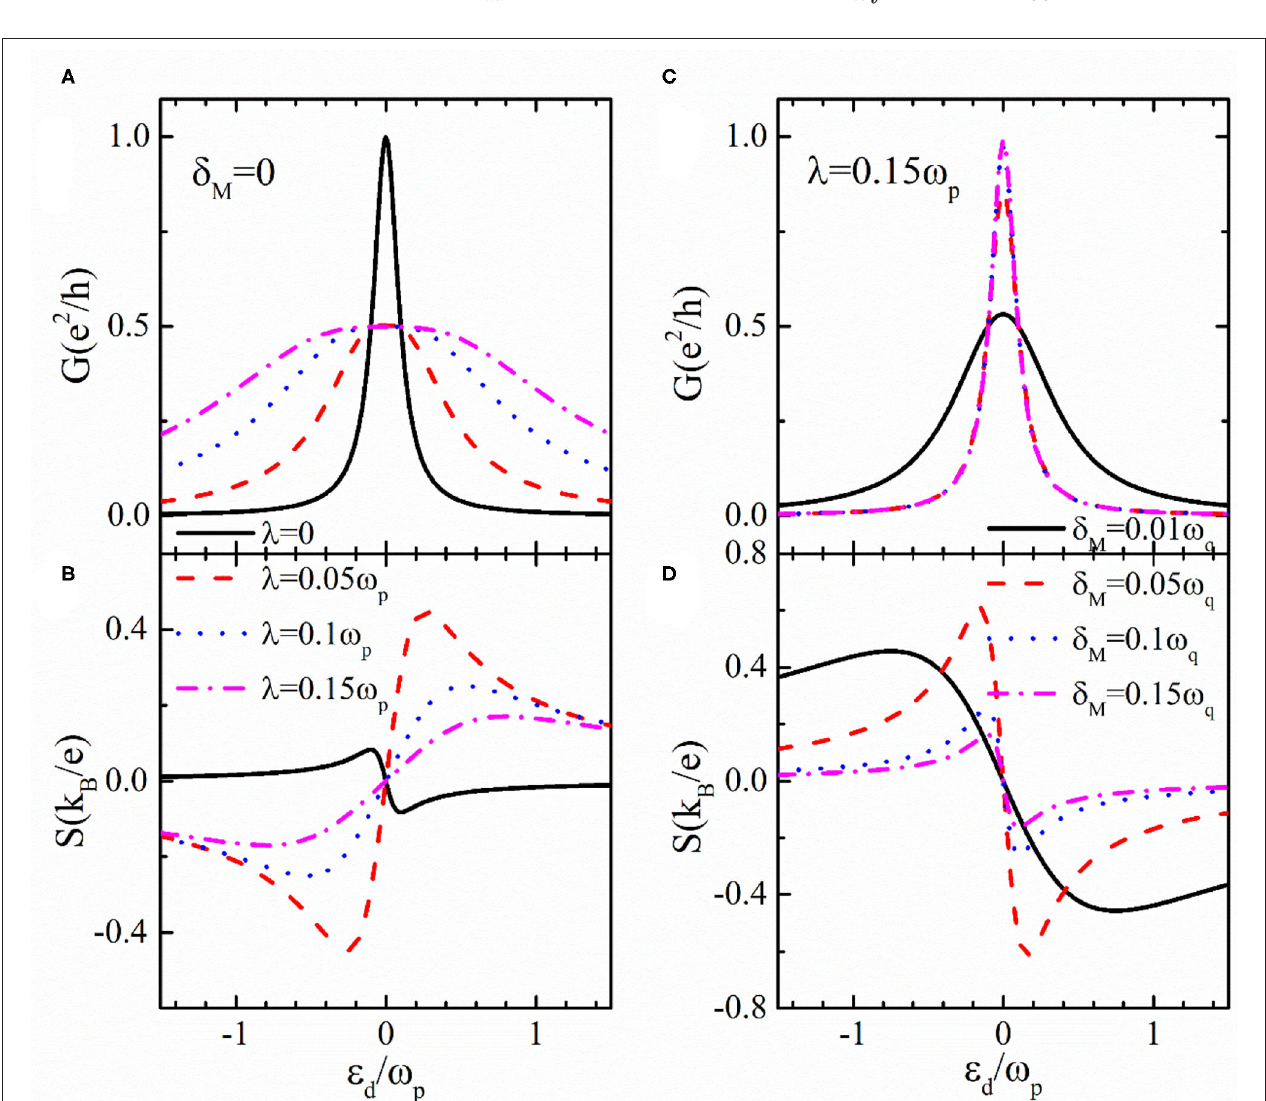
FIGURE 2 | Conductance and thermopower as functions of the dot level for different values of dot-MZMs coupling strength λ in (A) , (B) with a fixed value of δ M and for different δ M in (C) , (D) with fixed λ